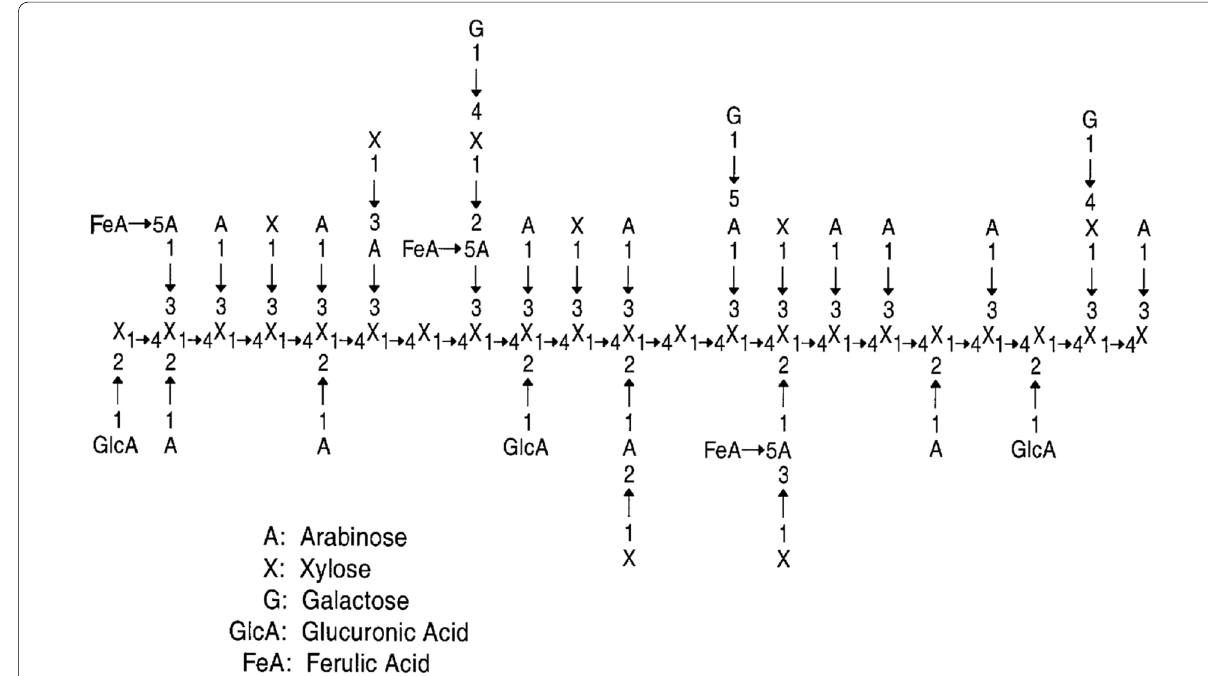
Fig. 2 Schematic structure of the sugar moiety of heteroxylans from corn fiber (Saha